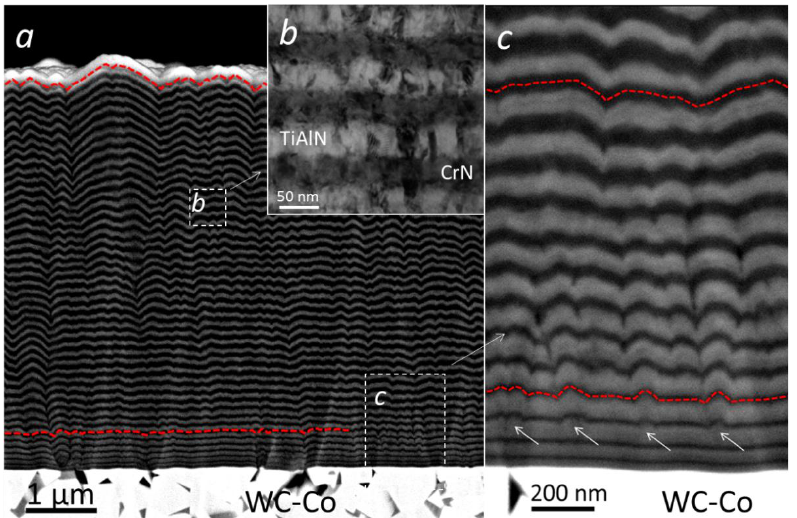
Figure 5. Bright-field cross-sectional SEM image of the NL-TiAlN/CrN coating deposited on cemented carbide substrate using the two-fold rotation ( a ). The interlayer roughness gradually increases up to the top of the coating. Crystal grains in both types of layers are clearly visible in the inset TEM image ( b ). The area marked with the dashed frame is shown at higher magnification in bright-field cross-sectional STEM image ( c ). The first increase in interlayer roughness occurs in the TiAlN layer (see sites marked with arrows). Only a few studies concerning the interlayer roughness in the nanolayer hard coatings can be found in the literature. Recently, Beltrami et al. studied the development of inter- layer roughness in nanolayer coatings composed of alternated stoichiometric CrN and understochiometric WN layers [26]. The thickness of individual layers was between 10 nm and 100 nm. All coatings were nanocrystalline with grain sizes in the order of 7 to 20 nm with a face-centered cubic (fcc) crystal structure. They found that the surface roughness of nanolayer coatings is lower in comparison to monolayer CrN coatings of comparable total thickness. The difference is enhanced by reducing the thickness of individual constituent layers, i.e., with a larger number of individual layers. They analyzed the relative contribu- tion of CrN and WN layers to the overall roughness from the SEM image of FIB cross-sections, and they found that the interlayer roughness builds up with the deposition of each additional layer. They also observed that WN layers increase the overall roughness, while CrN layers slightly smoothed the surface. According to their explanation, the alter- nated deposition of two different material blocks the growth process of crystal grains, re- sulting in a finer grain size. Therefore, the volume fraction of the amorphous phase at the layer interfaces increases. The presence of the amorphous phase at the interface constrains the growth of crystal grains. Consequently, asperities due to misoriented grains are effec- tively reduced. Despite the same crystal structure, coherent growth was probably impossi- ble due to a too-large mismatch between the CrN and WN lattices. Their findings generally